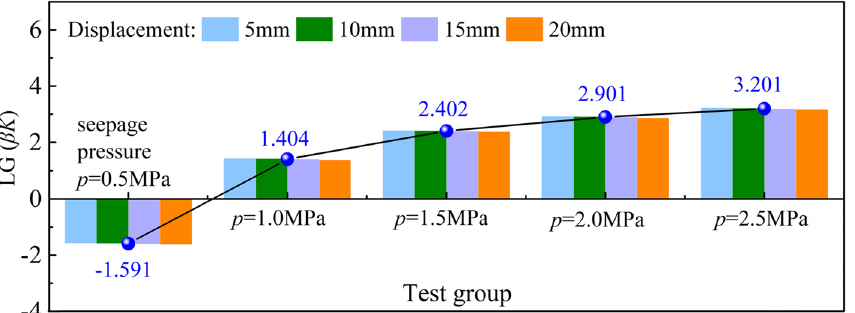
Figure 5. Relationship between β and K in sample A.